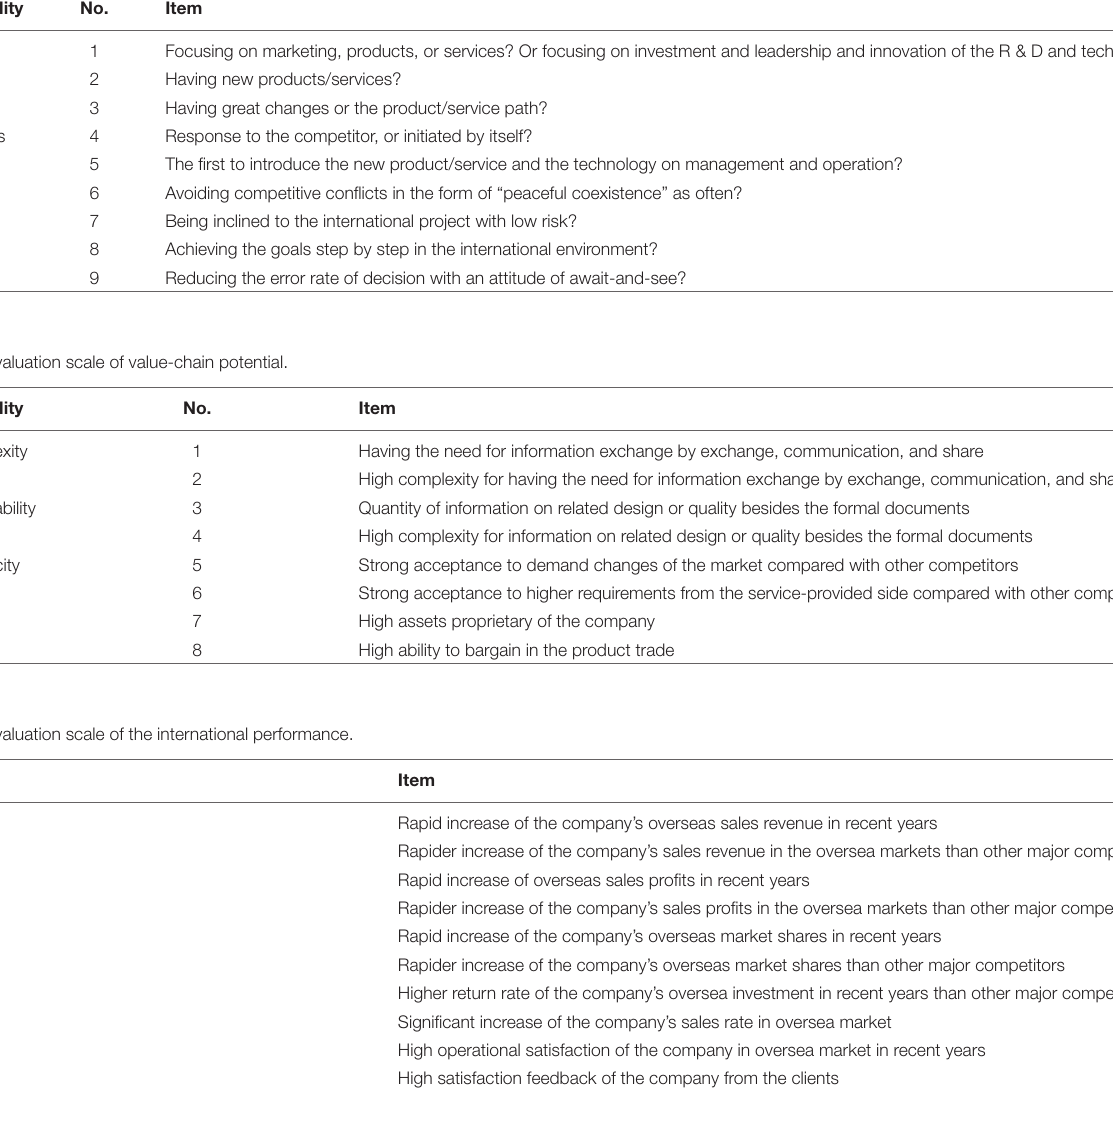
TABLE 1 | Evaluation scale of the multinational entrepreneurial orientation. Dimensionality